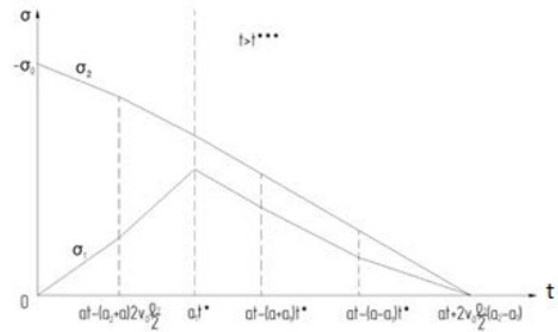
for it is a shock.